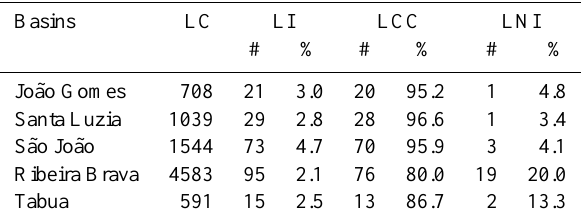
Table 2. Overall results of the validation stage. LC – number of landslide polygons classified; LI – number of landslides identified in the field; LCC – Landslide polygons correctly classified; and LNI – Landslides not identified in the images.